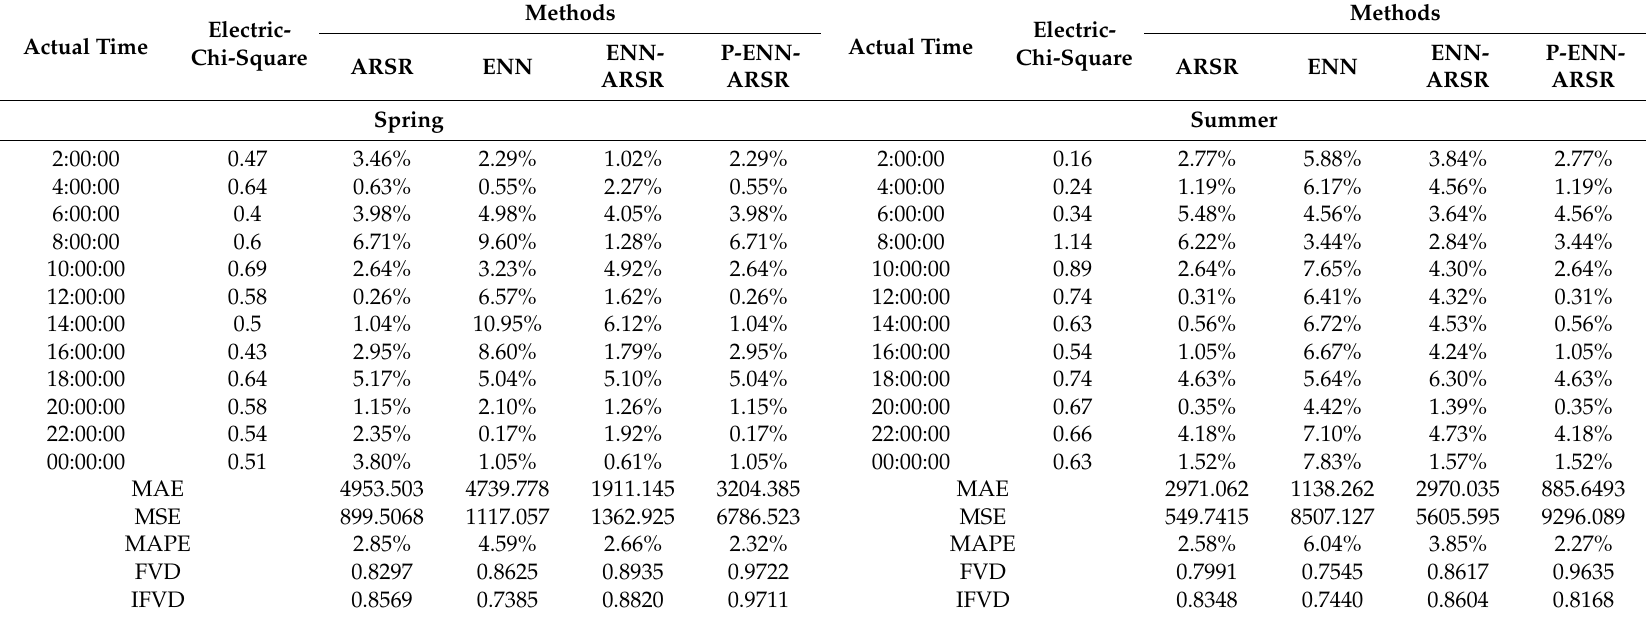
Table 5. The forecasting results of hybrid model in spring and